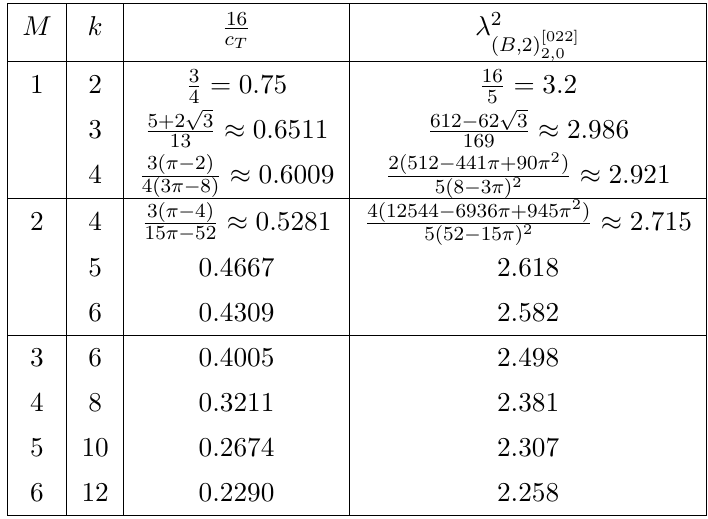
and λ 2 in various U(1) k × U(1 + M ) − k ABJ theories. c T ( B, 2) [022] 2 , 0